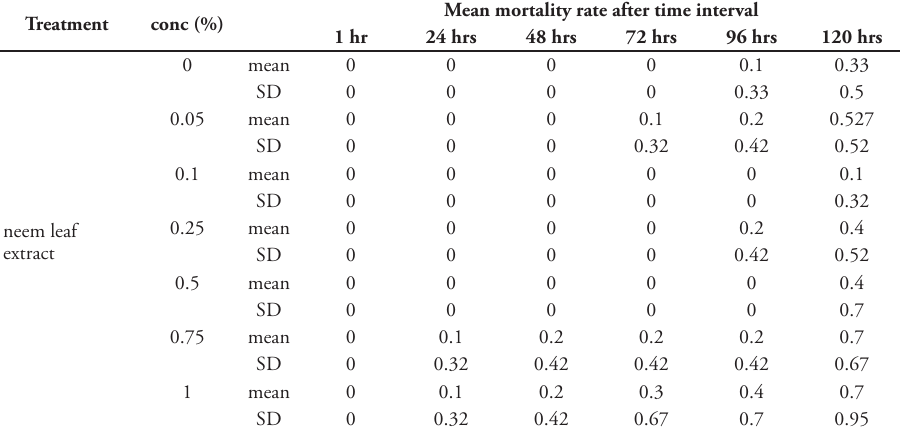
Table 2. Effect of neem leaf extract on the mortality of Porcellionides pruinosus expressed as cumulative mean for different time